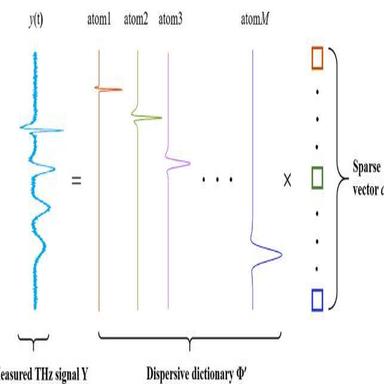
Schematic diagram of sparse representation for dispersive THz signal.